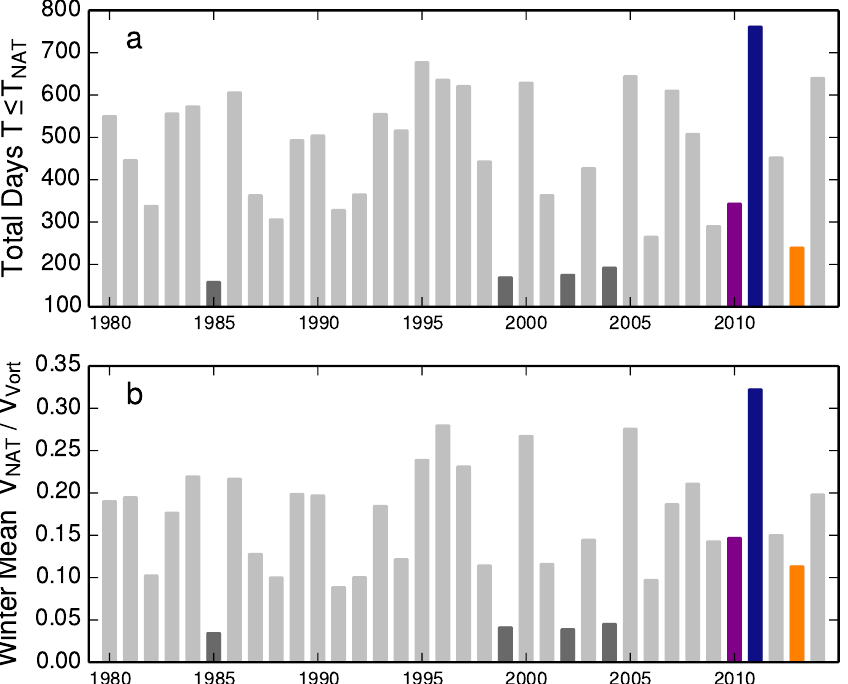
Figure 5. Summary temperature information from MERRA reanalysis for the past 35 Arctic winters: (a) the number of days below T NAT summed over isentropic levels from 390 to 550K; (b) winter mean V NAT /V Vort calculated from 1 December through 15 April. Years 2009/10, 2010/11, and 2012/13 are highlighted in purple, blue, and orange, respectively. Dark grey bars indicate other winters with major SSWs in December or early January. Year numbers are for the January of each